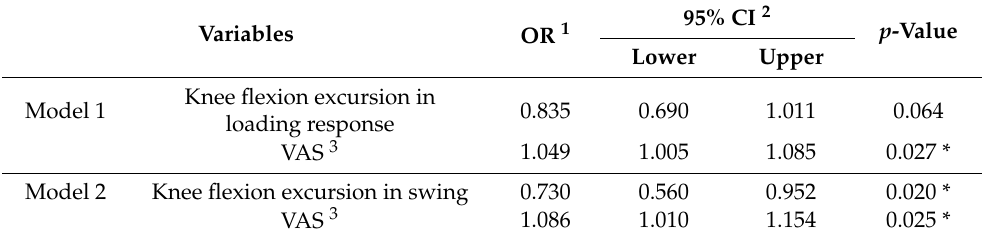
Table 2. Results of the logistic regression analysis between the groups with walking difficulty (Diff) and without walking difficulty (non-Diff).